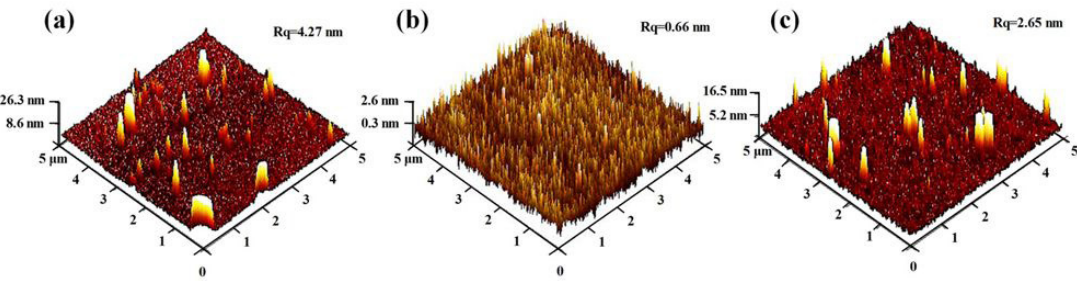
film, (b) an SRSO film, and (c) an Au film deposited on an SRSO film. Figure 5. AFM images of (a) a SiO x